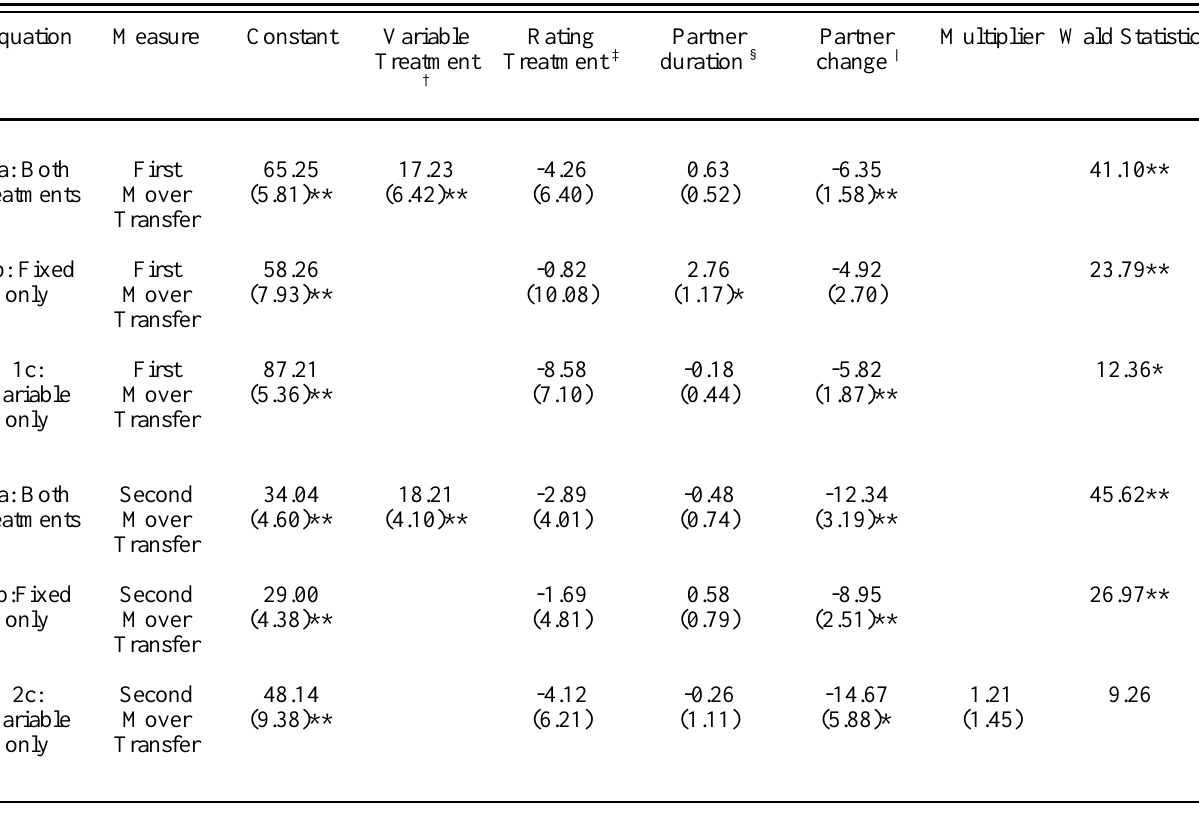
Table 3. Panel data analysis of